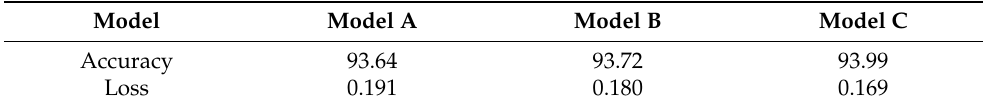
Table 5. Test results of different network